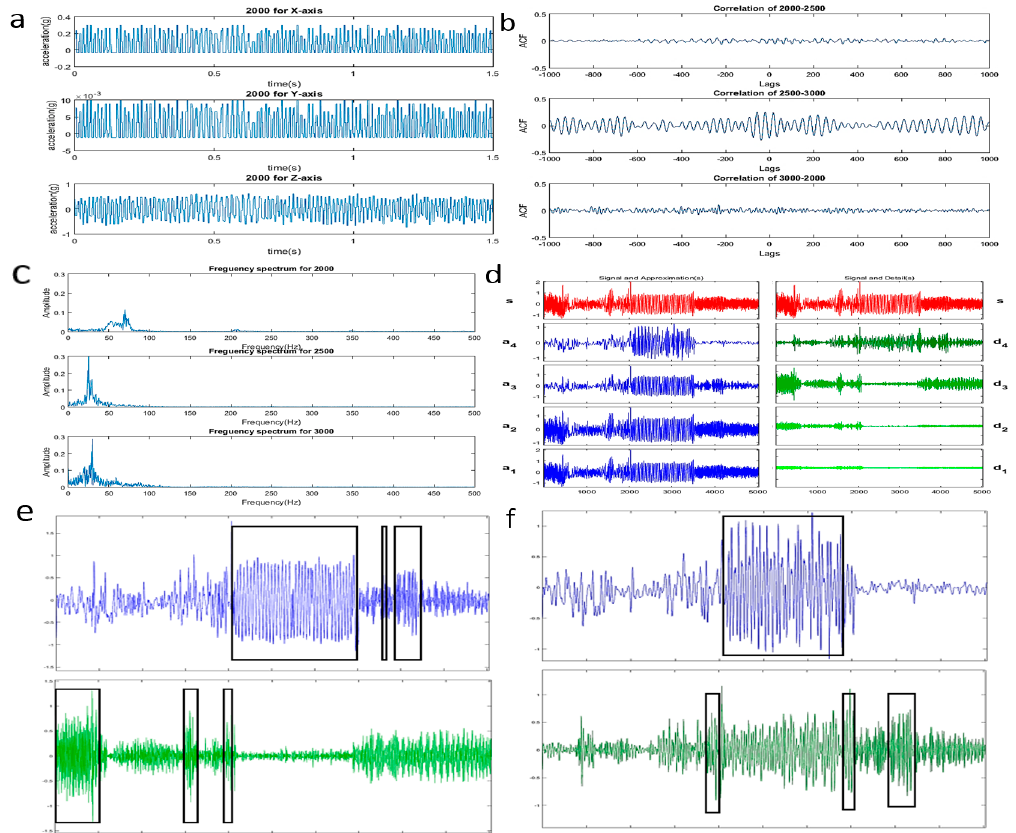
Figure 9. ( a ) The initial vibration signal of 2000 r/min, 2500 r/min, and 3000 r/min; ( b ) cross correlation analysis of the three sets of signals; ( c ) spectrum of the three sets of signals; ( d ) four level wavelet decomposition of the vibration signals; ( e ) the third level wavelet decomposition, upper (0 Hz–62.5 Hz), lower (62.5 Hz–125 Hz); ( f ) the forth level wavelet decomposition, upper (0 Hz–31.25 Hz), lower (31.25 Hz–62.5 Hz).